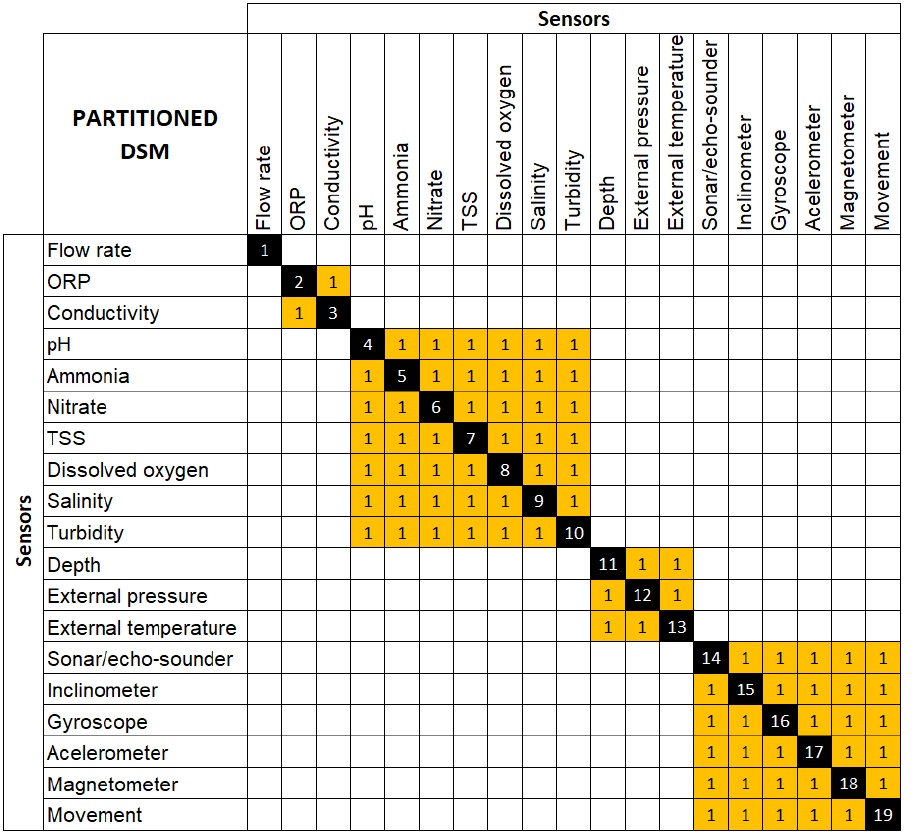
Figure 10. DSM application result.